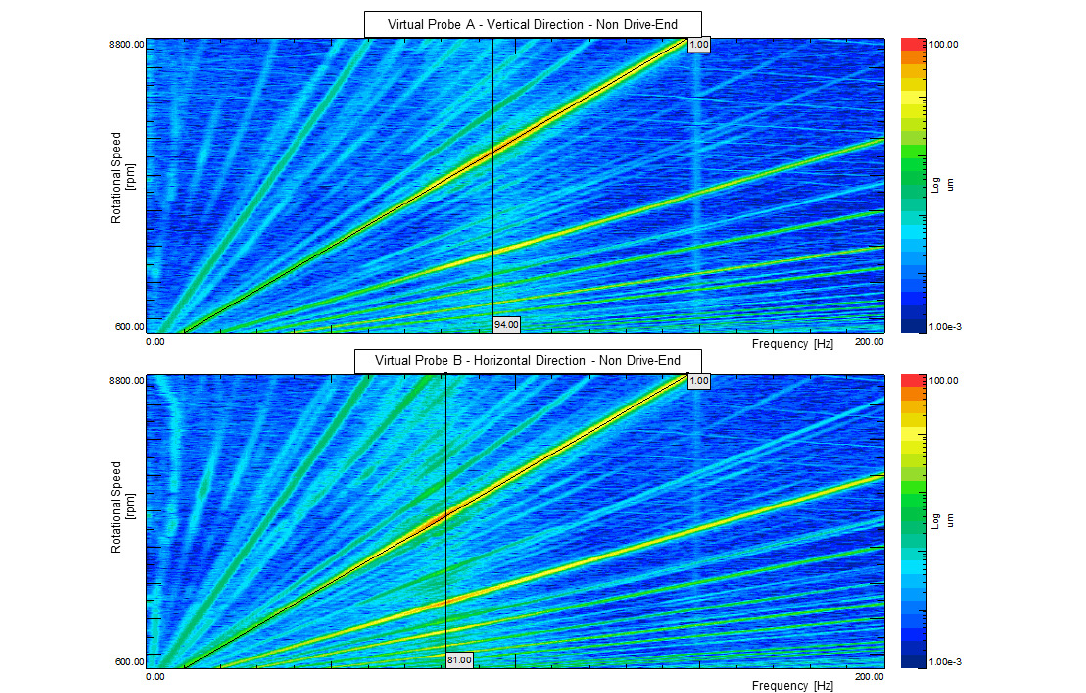
Figure 12. Color map of the active damper condition for the 1.4 kN static load case with 120 gmm unbalance